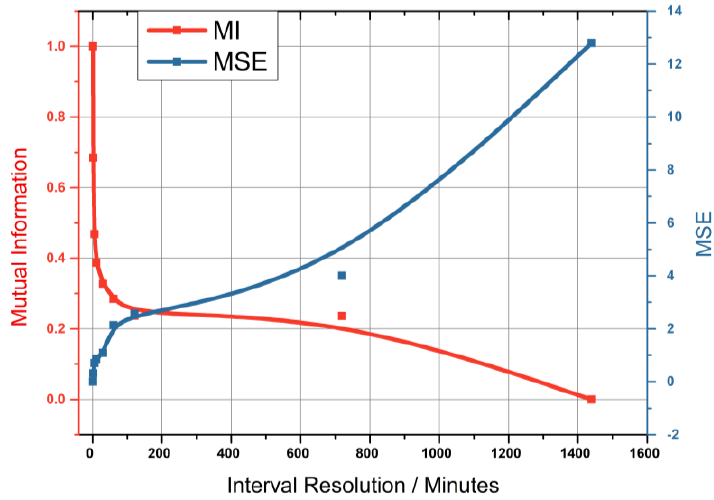
ff erent interval